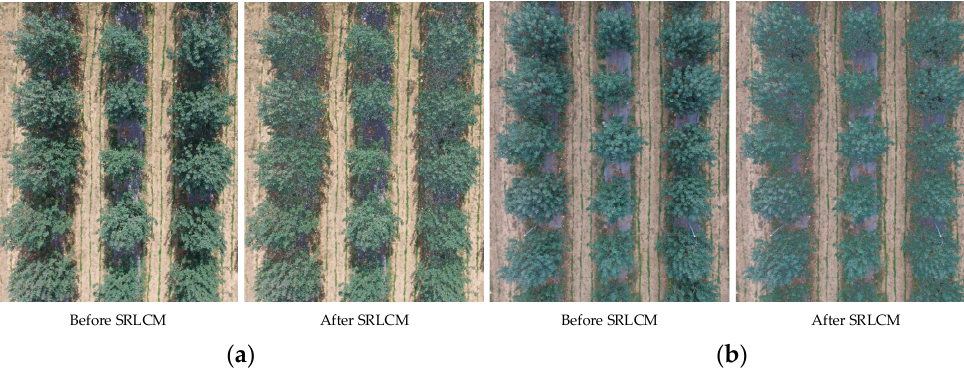
Figure 6. Results of image preprocessing using the shadow region luminance compensation method (SRLCM) algorithm. ( a ) Images of fruit trees that were taken under sunny conditions; ( b ) images of fruit trees that were taken under cloudy conditions.